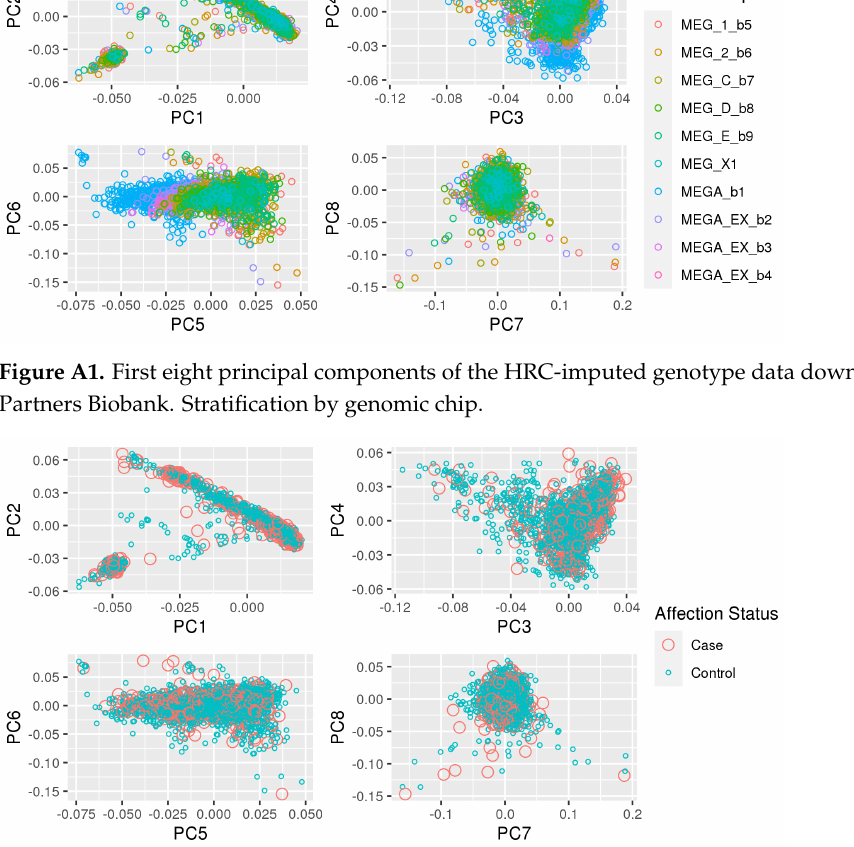
Figure A2. First eight principal components of the HRC-imputed genotype data downloaded from Partners Biobank. Stratification by affection status.